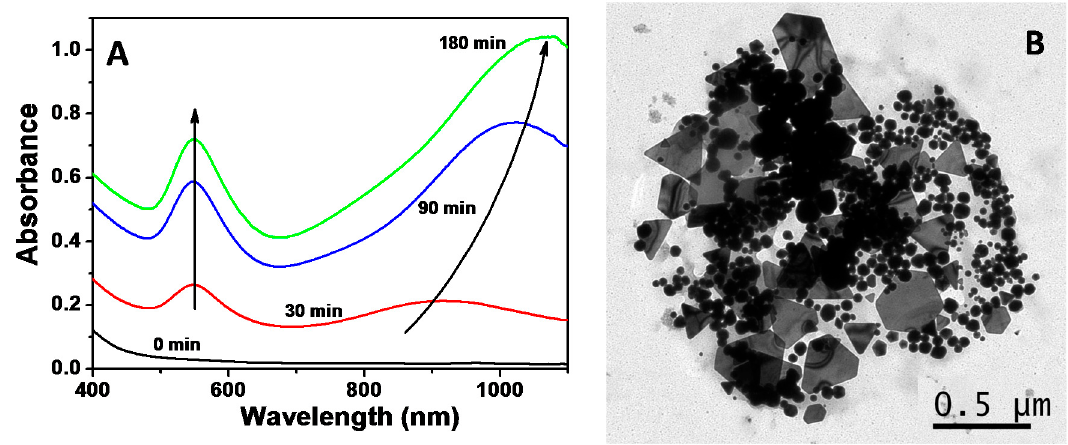
Figure 2. ( A ) Time evolution of visible-NIR spectra during the synthesis of AuNPs in the presence of the biosurfactant extracted from corn steep liquor (CSL) at 60 °C. ( B ) Representative transmission electron microscopy (TEM) image of the synthetized nanoparticles (NPs).